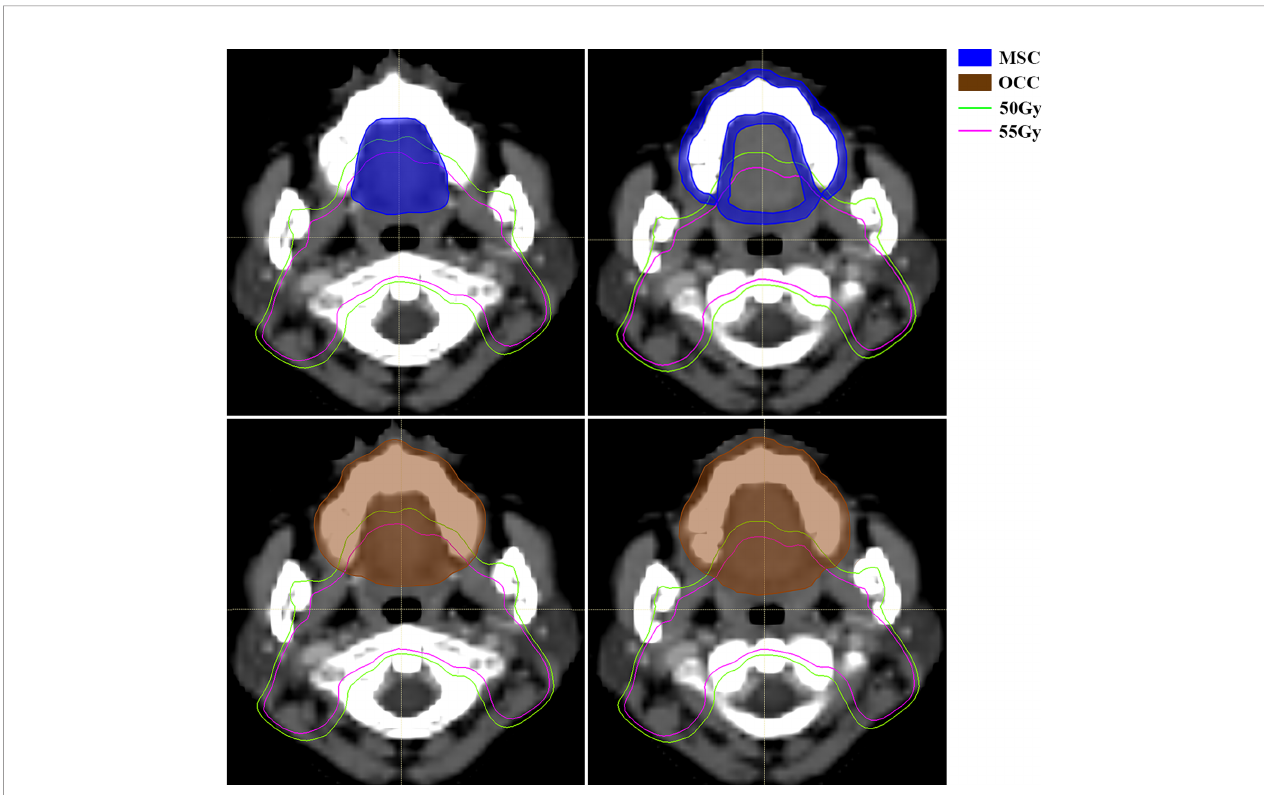
FIGURE 4 | Computed tomography (CT) scan of a nasopharyngeal carcinoma patient with mucosal surface contours (MSC) (up, area fi lled with blue) and oral cavity contours (OCC) (down, area fi lled with brown). MSC involves the mucosal surface while OCC encompass more solid tissue, like tongue, maxillary bone, etc. The green line and pink line are isodose curve of 50Gy and 55Gy respectively. Abbreviations: OCC, oral cavity contouring; MSC, mucosa surface